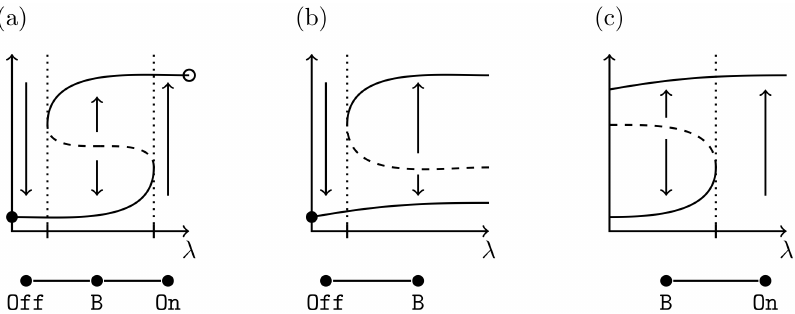
Fig 1. Hysteresis and resettable bistability. Solid (dashed) lines indicate stable (unstable) equilibria for fixed values of input, Off = Low Equilibrium, B = Bistability, and On = High Equilibrium. Resettable bistability: When input signal is withdrawn from a bistable system, and the system resets to the low equilibrium (filled circle). Hysteresis: In addition to resettable bistability, when signal is increased, system goes to high equilibrium (circle). (a) Hysteresis; (b) resettable bistability, but not hysteresis. (c) No resettable